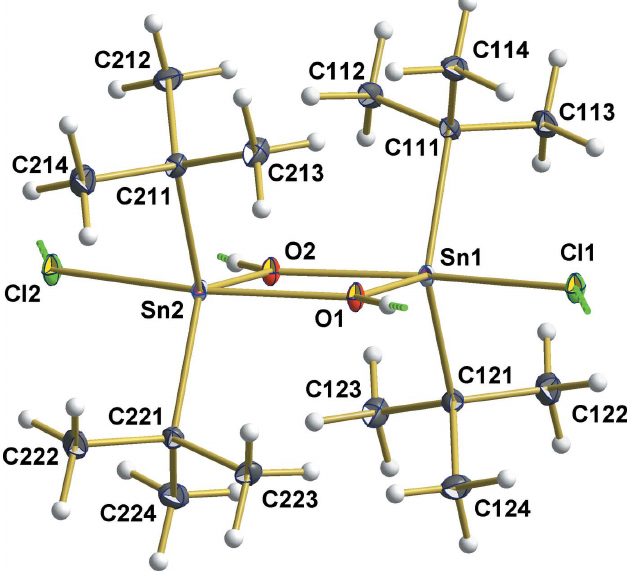
Figure 1 A representation of the dimeric, non-symmetric molecule found in the crystal of [ t Bu 2 Sn(OH)Cl] 2 , showing the atom numbering. With the exception of the hydrogen atoms, which are shown as spheres of arbitrary radius, all other atoms are drawn with displacement ellipsoids at the 40% probability level. Intermolecular O—H (cid:2)(cid:2)(cid:2) Cl hydrogen bonds are indicated by dashed sticks in